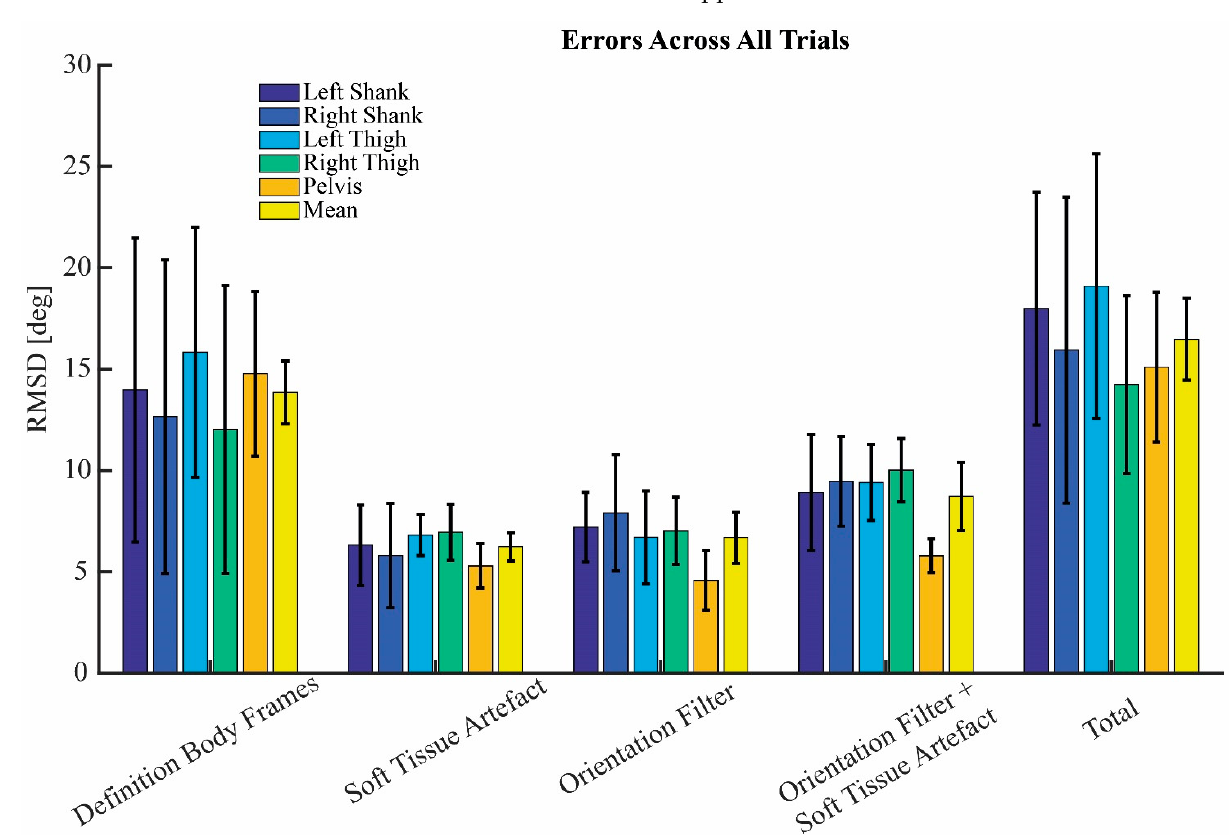
Figure 7. Root-mean square differences (RMSD) and standard deviations for each of the sources of error, and total error, for all body segments, mean over all trials. The error of the definition of the body frames and the total error is displayed for calibration A.